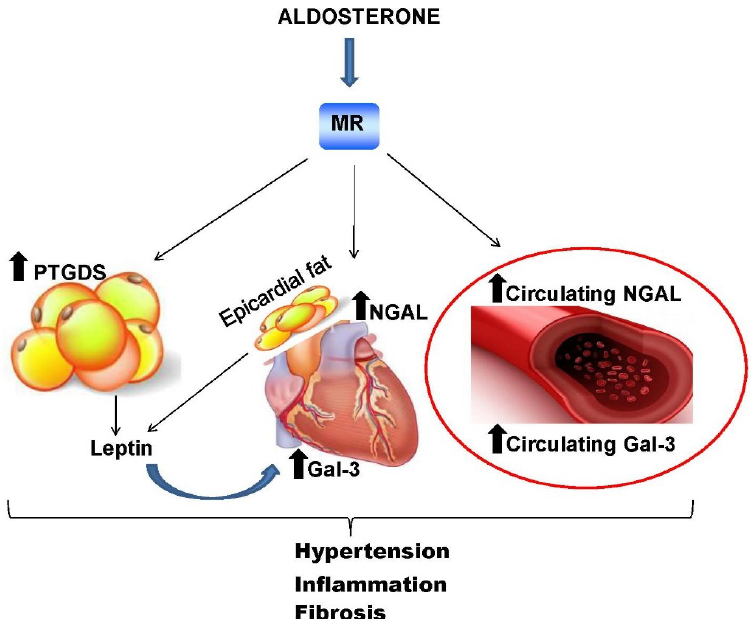
Figure 3. PTGDS, NGAL and Gal‐3 as novel biomarkers in cardiovascular diseases induced by altered mineralocorticoid activation. MR activation by aldosterone induces the expression of different downstream molecules. PTGDS is expressed in adipose tissue, whereas NGAL and Gal‐3 are expressed in the heart and vasculature; NGAL and Gal‐3 are also detectable in the plasma. In obesity states, elevated leptin levels secreted by adipose tissue (in particular epicardial fat), directly activate heart MR, which in turn further promotes Gal‐3 synthesis. All these molecules contribute to induce end‐organ damage, through disarrangement of ECM and collagen. PTGDS: lipocalin‐like prostaglandin D2 synthase; NGAL: neutrophil gelatinase‐associated lipocalin; Gal‐3: galectin‐3.